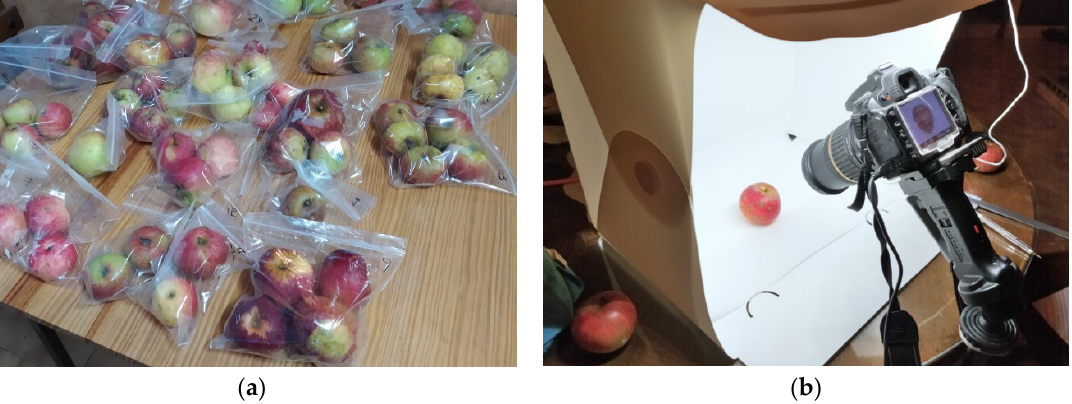
Figure 3. Apple samples and photographic system: ( a ) Selected apple specimens; ( b ) Nikon D90 camera and lightbox.